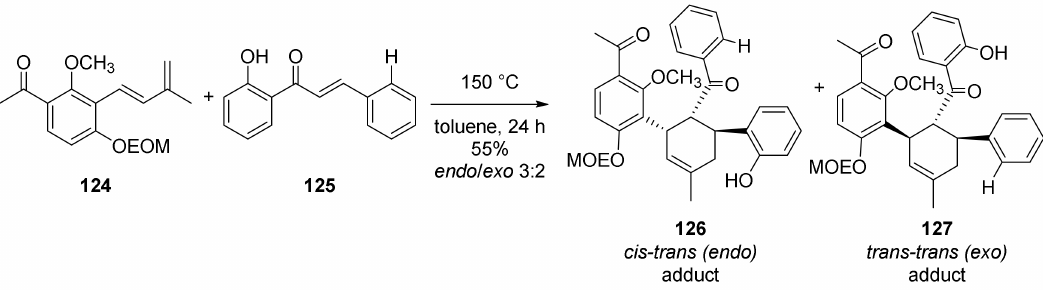
Figure 41. Development of initial methodology; best results achieved with model diene 124 and dienophile 125 .